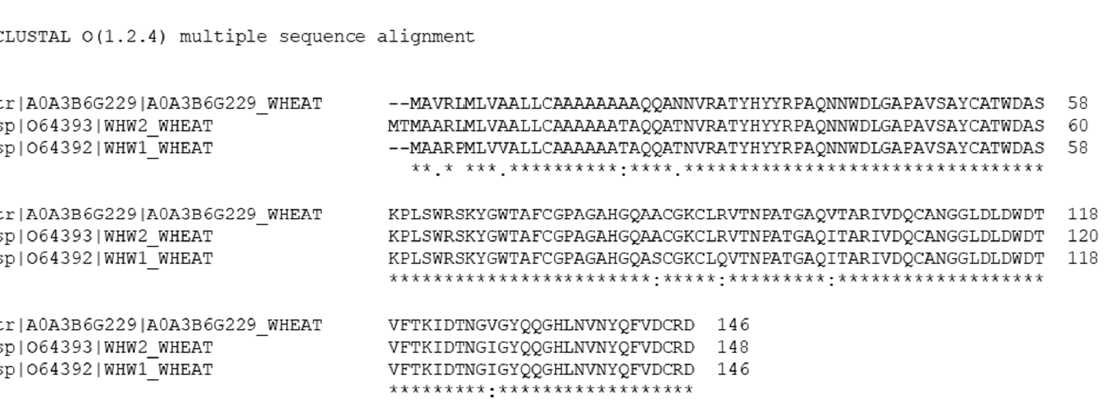
Figure 7. Alignment of the tr|A0A3B6G229, sp|O64393, and sp|O64392 entries. Alignment displays the consensus symbols, denoting the degree of conservation observed in each